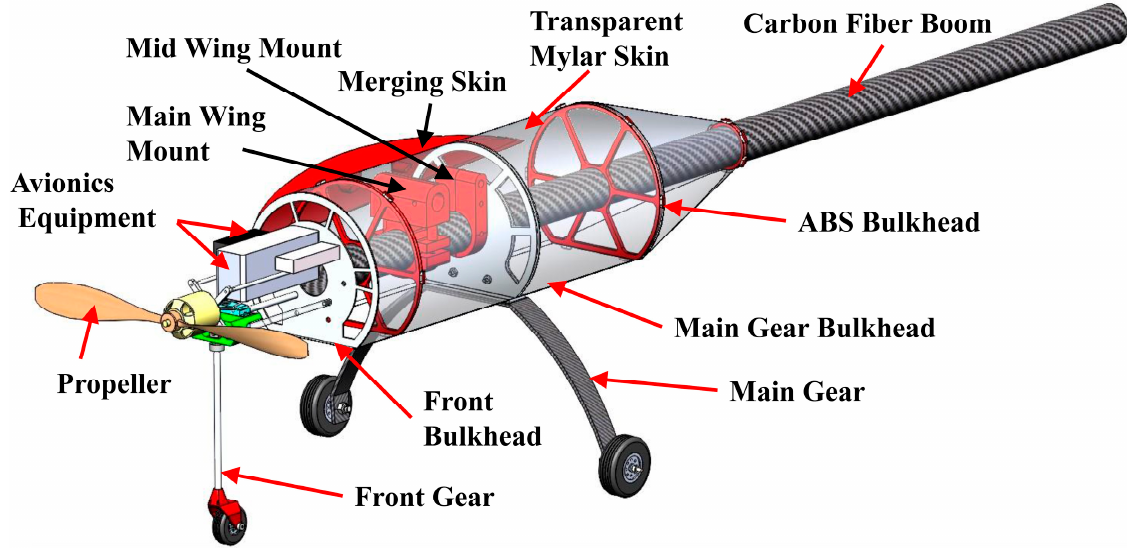
Figure 11. MM-3’s fuselage assembly .